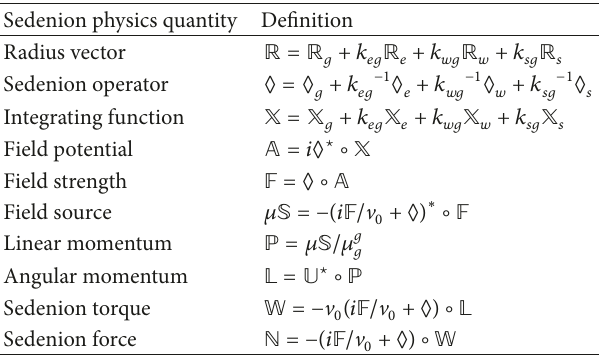
Table 2: Some physical quantities and definitions relevant to the four fundamental interactions, in the classical mechanics described with the